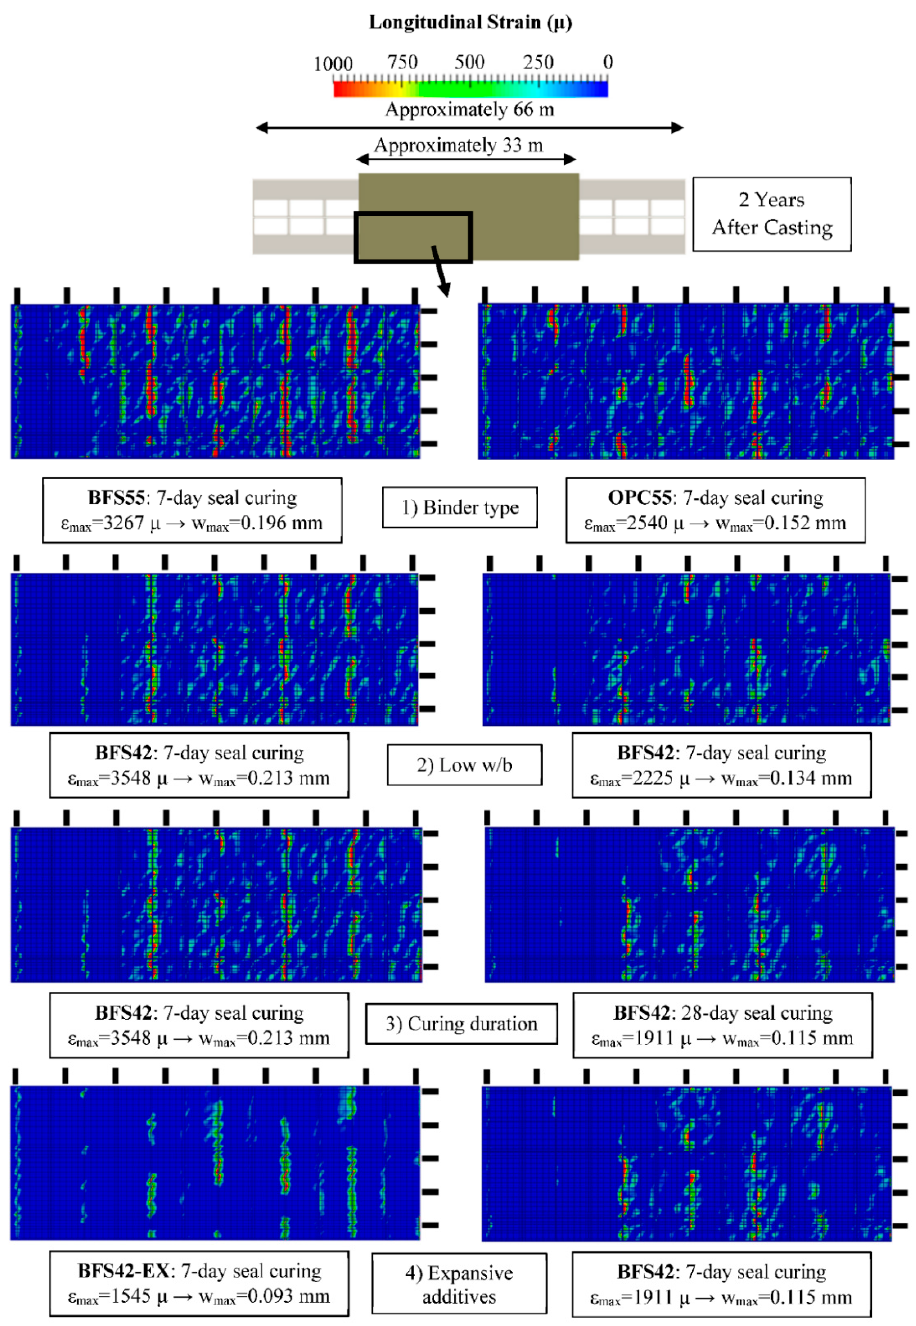
Figure 18. Parametric study focusing on four different aspects. * ε max = maximum longitudinal strain; w max = maximum crack